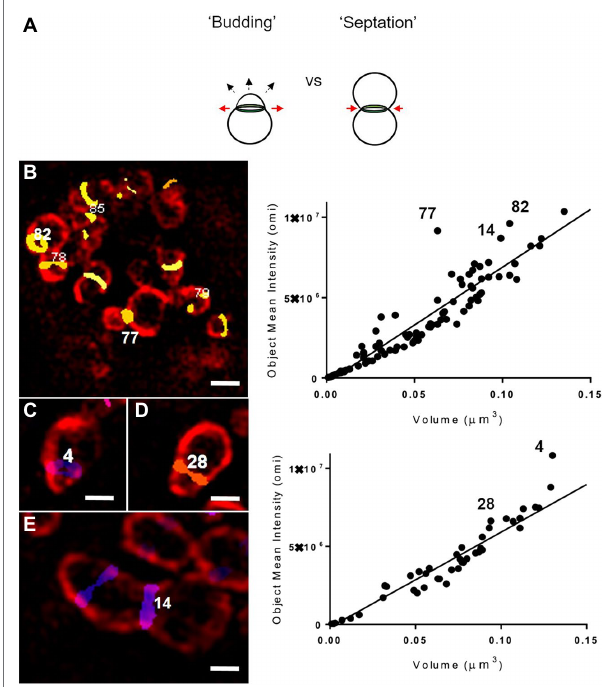
FIGURE 3 | Both “budding” and “septation” processes are associated with PG-labeled objects with higher mean fluorescent intensity values. (a) Illustration of the budding and septation stages of the chlamydial division process. The budding phenotype is defined by the polar expansion of the bacterial membrane (dashed arrows) and the expansion of the PG ring (red arrows), whereas septation is defined by the constriction of the PG ring (red arrows), resulting in two daughter cells of equal size. Representative images displaying C. trachomatis RBs undergoing either the initial “budding” (b–d) or the terminal septation (e) stage of their division cycle. RBs are labeled with a monoclonal antibody for MOMP (red) and PG-labeled objects are displayed utilizing a colorimetric “heatmap” corresponding to their relative Z plane positioning within an inclusion. Images are representative of observations made for 51 inclusions >5 μ m (b,e) and 49 inclusions ≤ 5 um (c,d) . Scale bars ~1 μ m (b) and ~ 0.5 μ m (c–e) . Each PG-labeled object was assigned a numerical value that can be viewed as a function of its volume and mean intensity measurement (right panels). Variance from the linear regression line represents an object’s relative divergence from the average integrated density for all objects within an